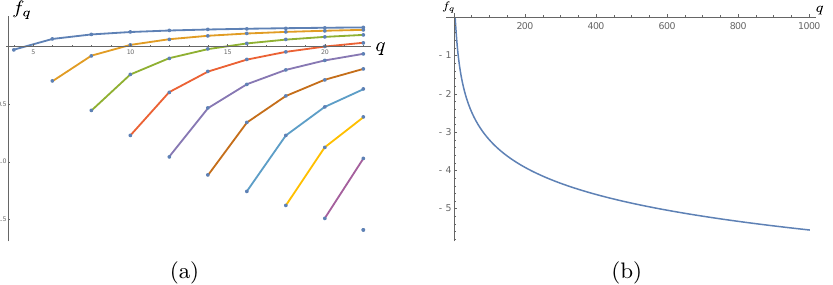
q for di(cid:11)erent values of q .